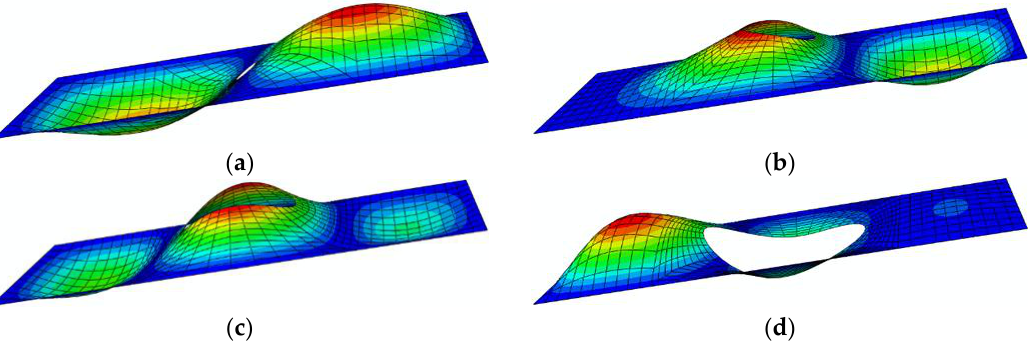
Figure 10. The model shapes of plates with e x / b = 1, β = 2 and BCs of 4S. ( a ) d / b = 0. 1 ; ( b ) d / b = 0.3 ; ( c ) d / b = 0.5 ; ( d ) d / b = 0.7.